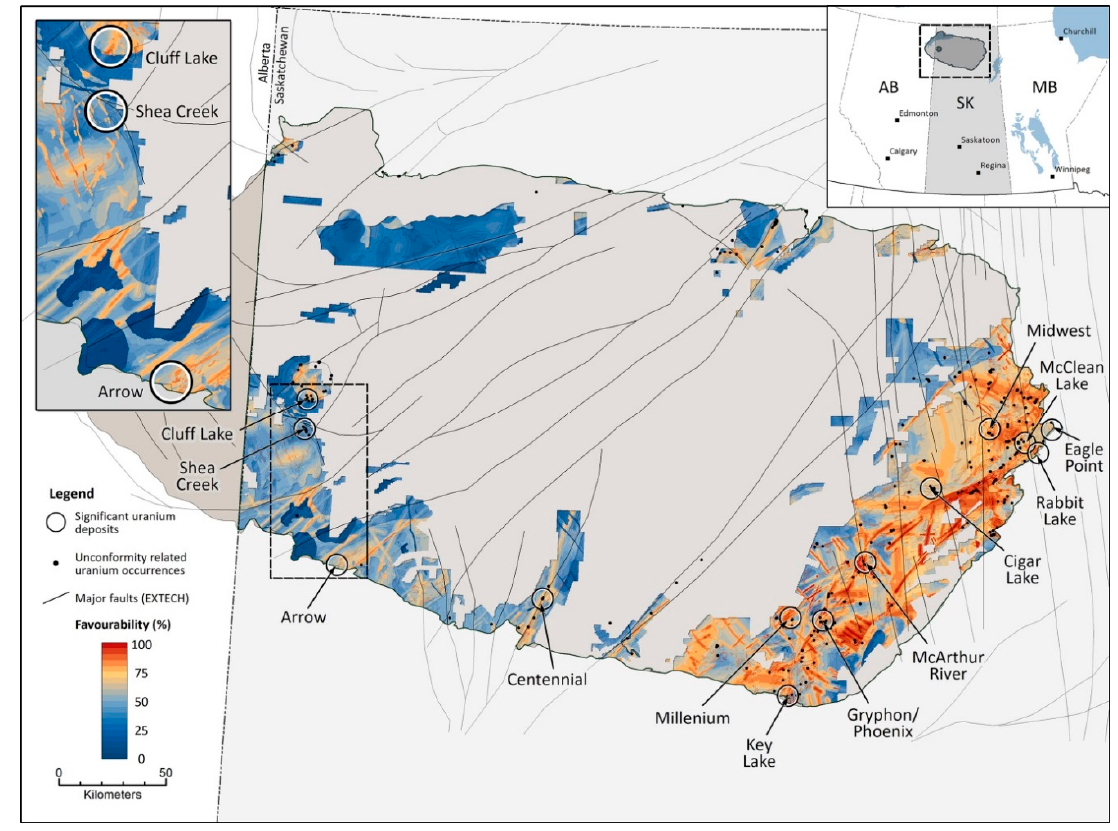
Figure 13. Final output from the Athabasca Basin fuzzy logic mineral potential modelling for unconformity-type uranium. Warmer colours (orange to red) represent elevated prospectivity. The locations of significant unconformity-related uranium deposits are shown by black circles. Due to the proprietary nature of the study, only results from areas covered by active mineral dispositions are shown.